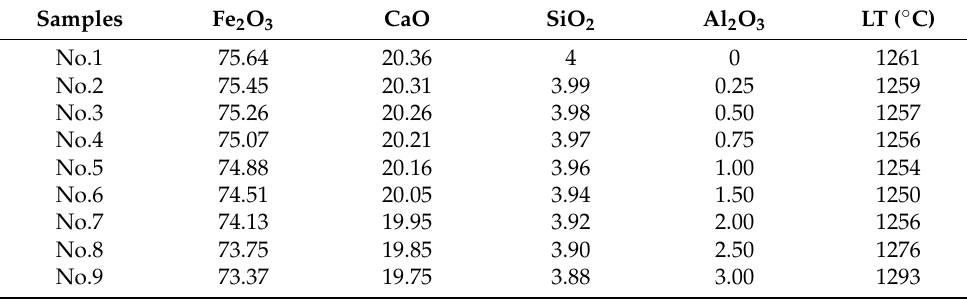
Table 1. Chemical Compositions of samples (mass